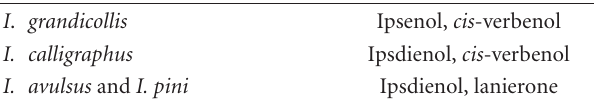
Table 7: Baits suggested for monitoring bark beetles in the genus Ips in southeastern